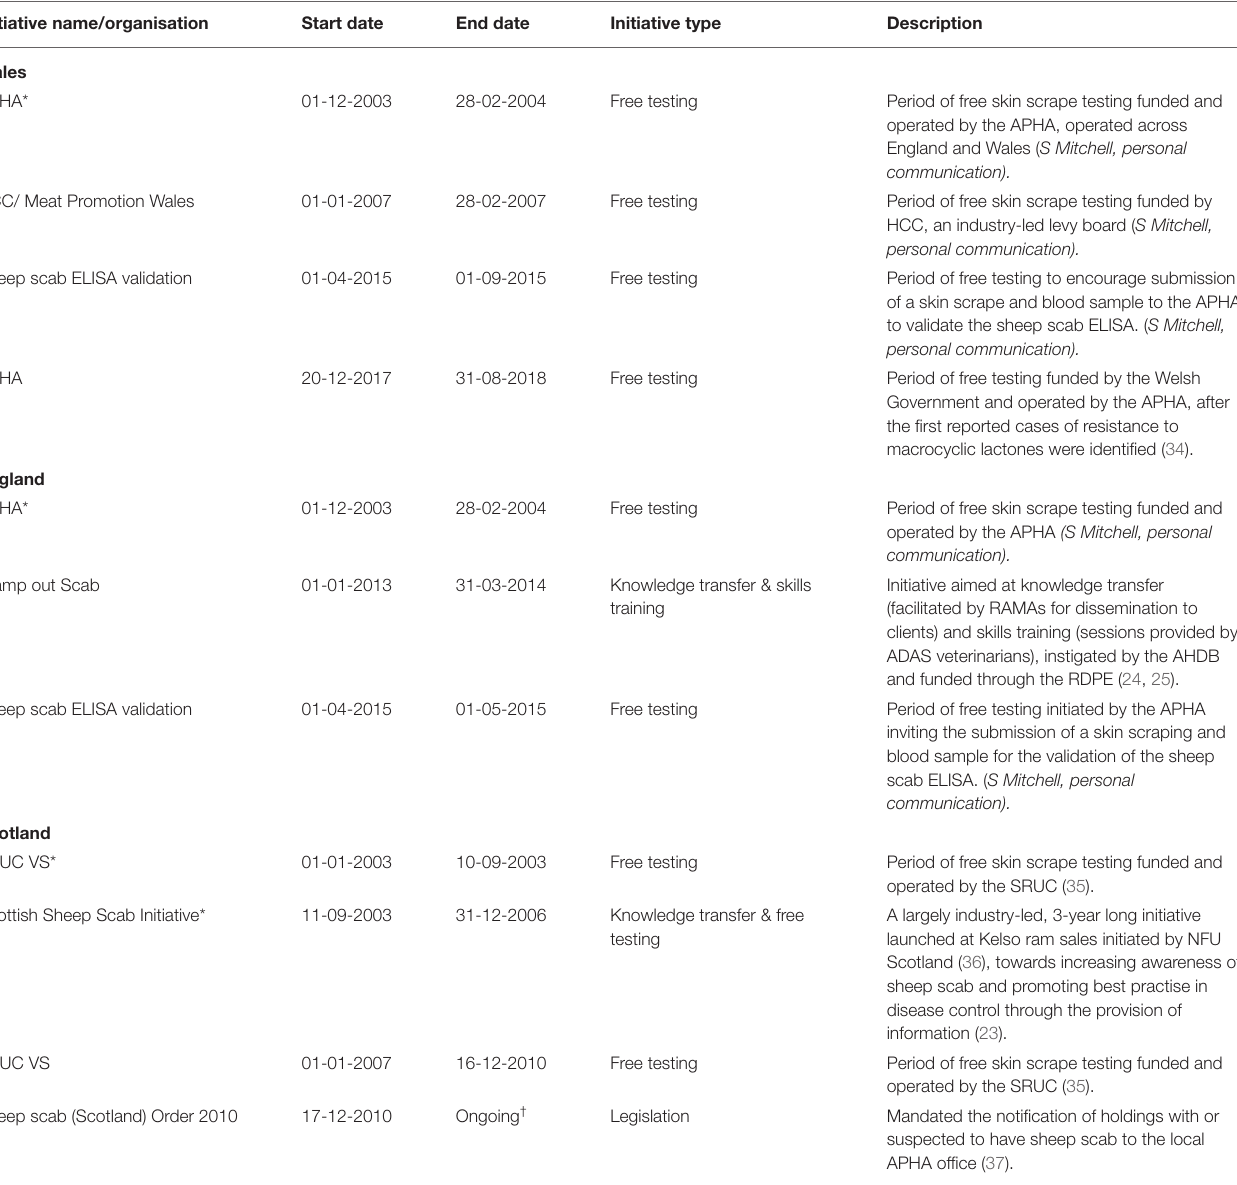
TABLE 2 | Description of the targeted national sheep scab disease control initiatives occurring between the 1st January 2003 and 31st December 2018 in